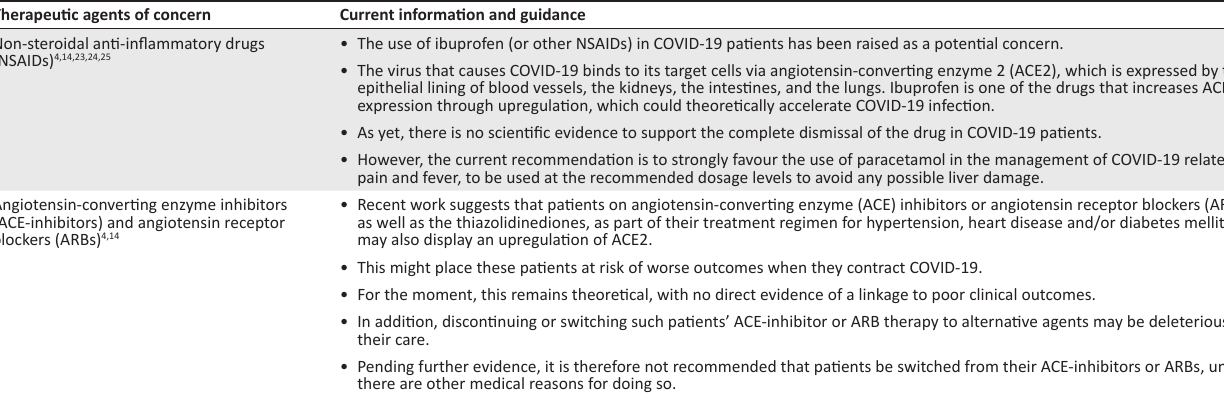
TABLE 3: Therapies of concern in COVID-19 patients. 4,14,23,24,25 Therapeutic agents of